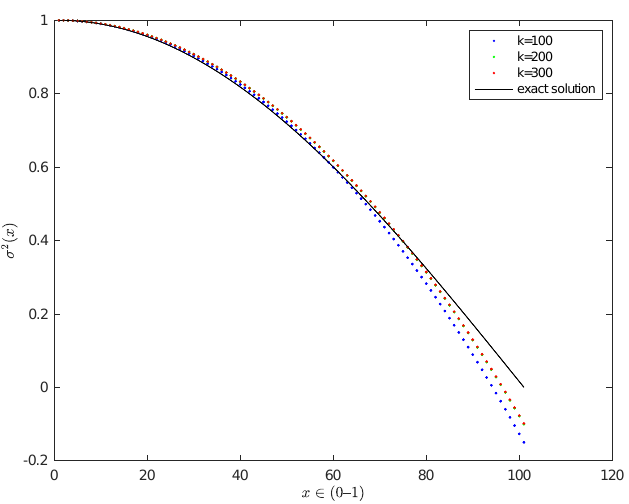
Figure 1. Numerical solution of unknown function σ 2 ( x ) with various iterations for Example